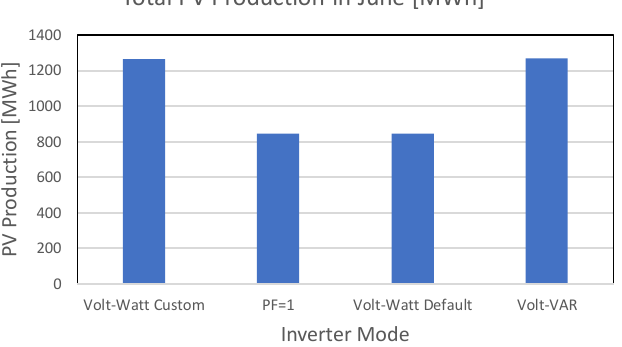
Figure 11. Total photovoltaic (PV) energy produced in June for different inverter modes.